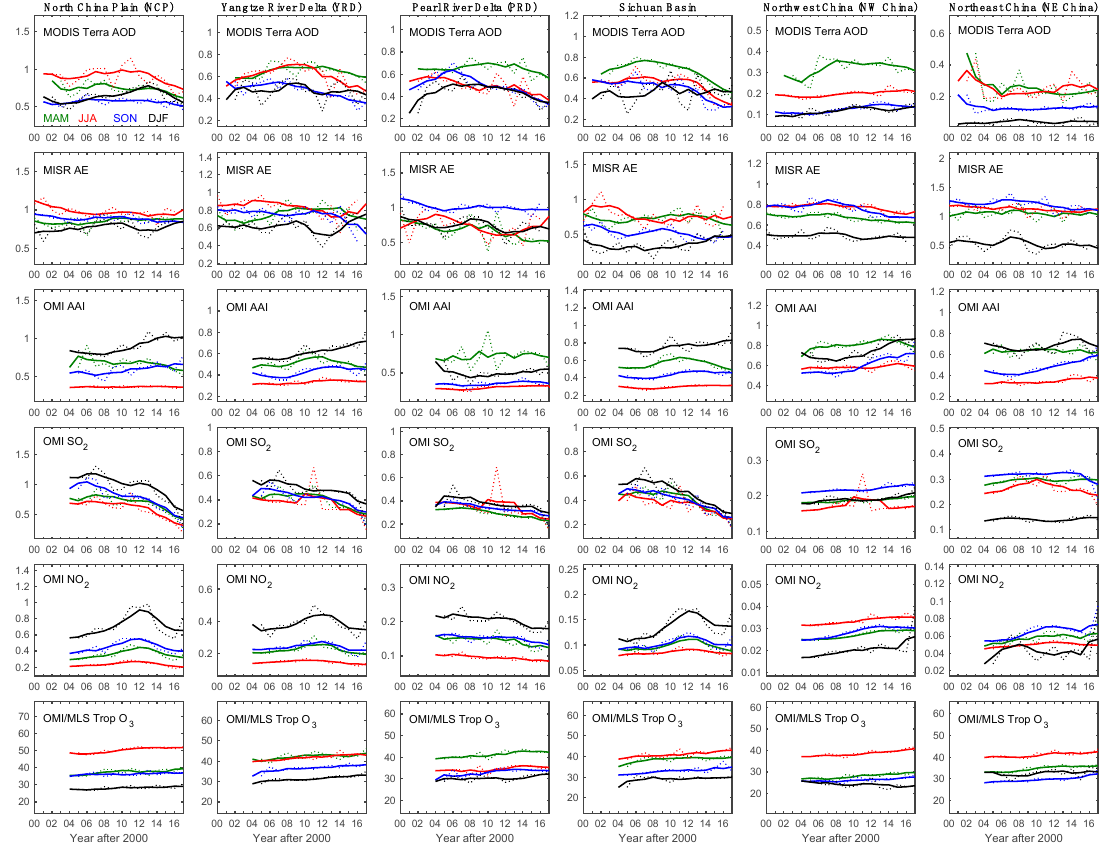
Figure 18. Similar to Figure 15, but showing the seasonal time series. The dotted lines represent annual time series and the solid lines show the four year running means.